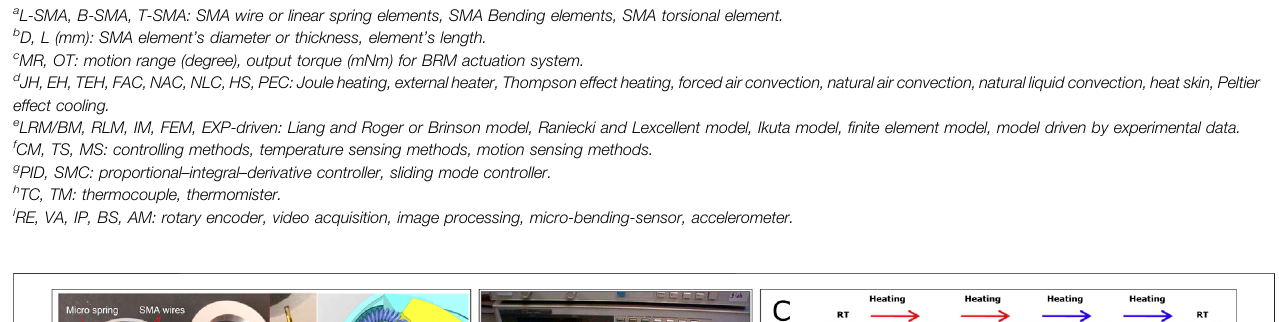
Frontiers in Robotics and AI |